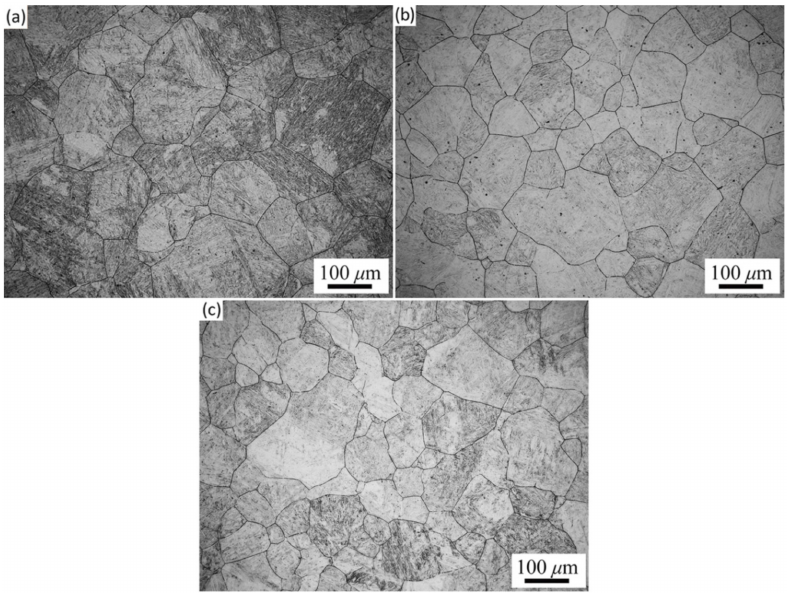
Figure 13. Microstructural evolution of the matrix at 1000 ◦ C under various hot pressures for 30 min: